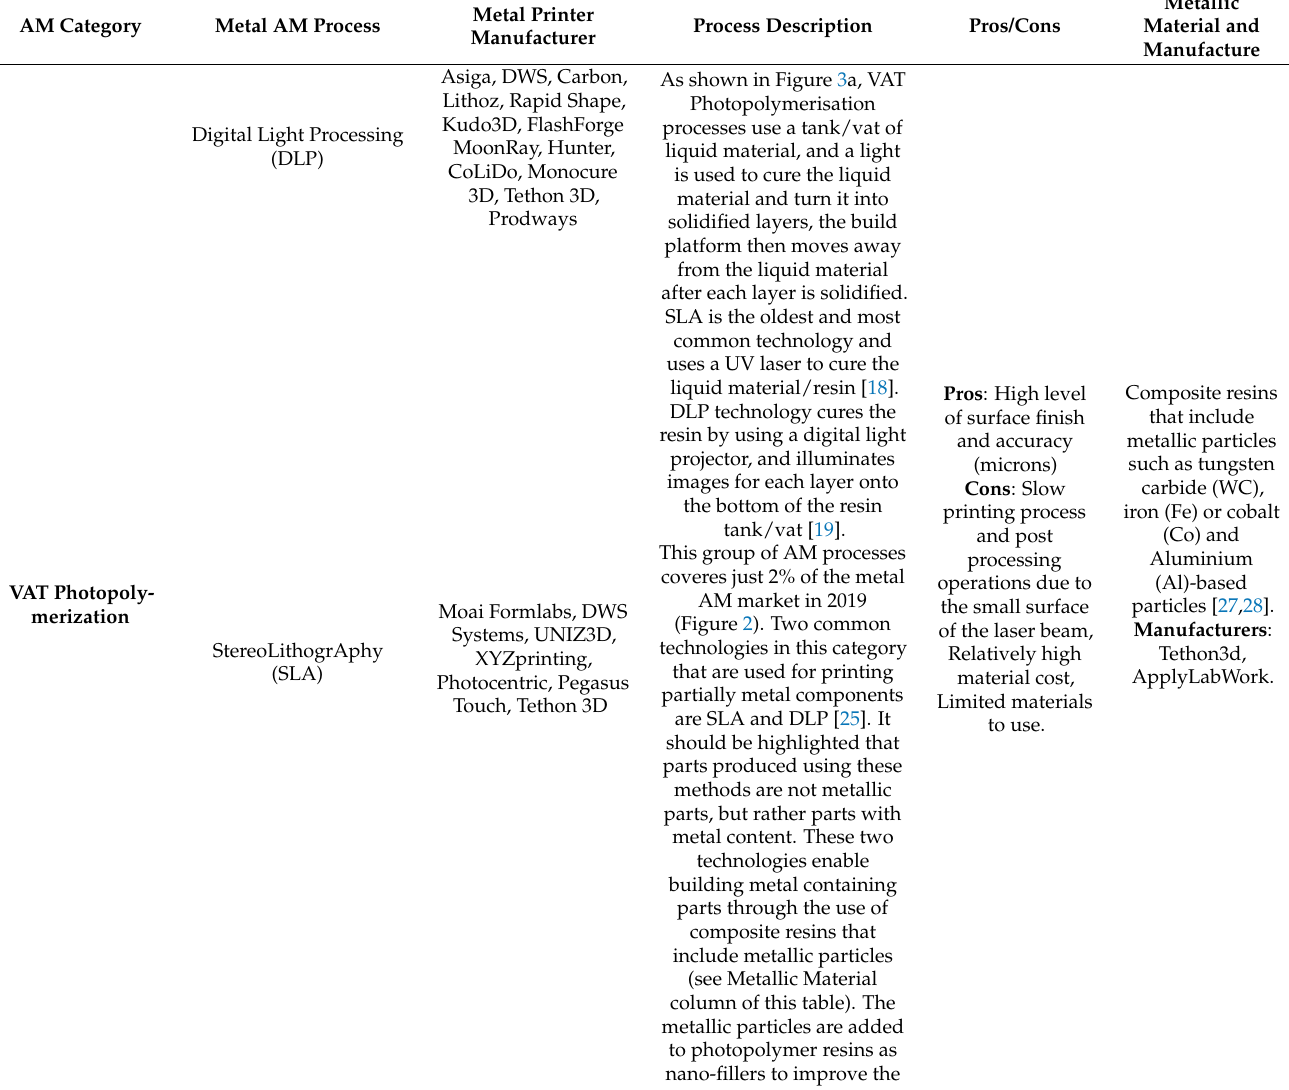
Table 1. AM Categories and Summary of the Common Metal AM